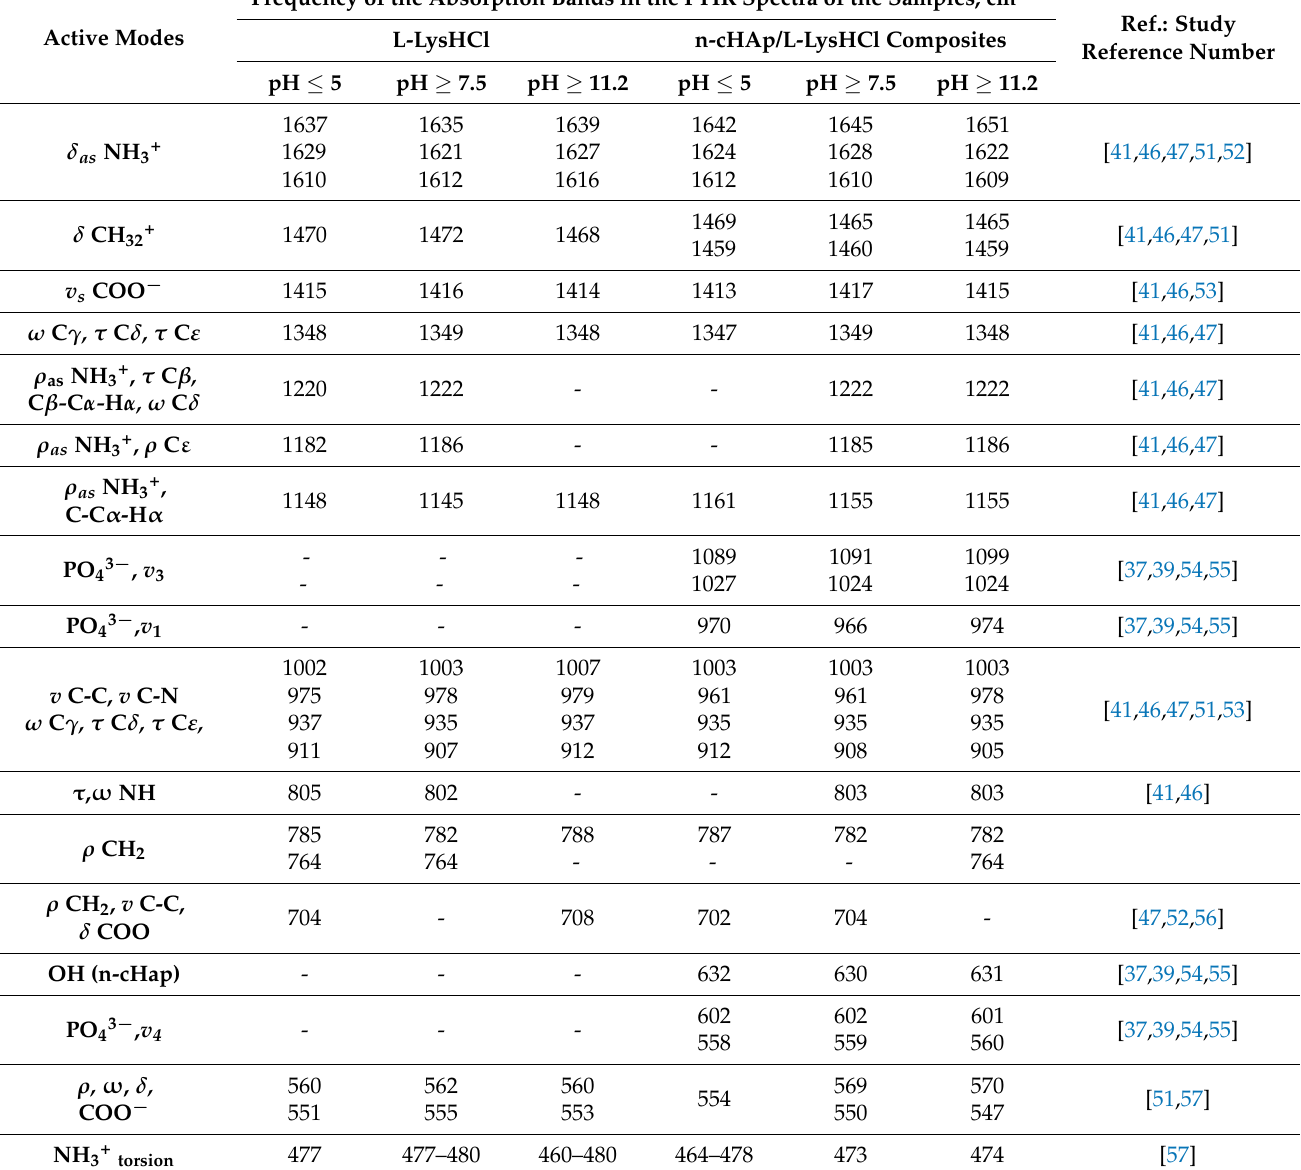
Table 2. Active modes in the FTIR absorption spectra of L-LysHCl samples and n-cHAp/L-LysHCl biocomposites, as well as their molecular group